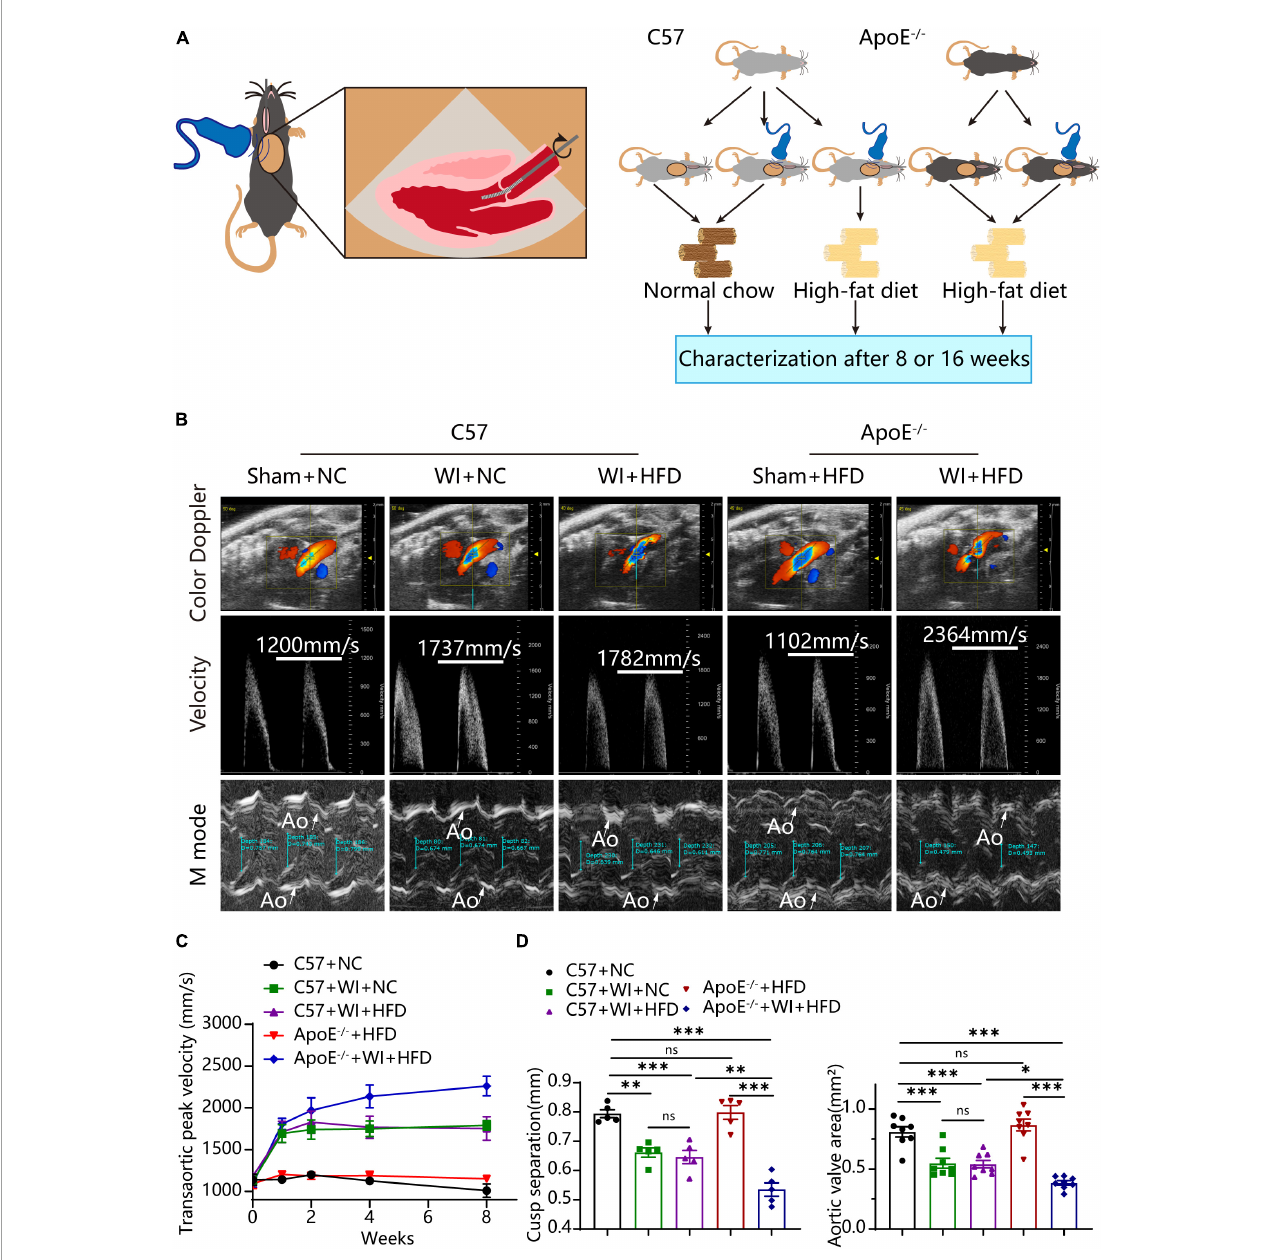
FIGURE1 Combined mechanical injury and hyperlipidemia caused aortic valve stenosis. (A) Schematic overview of the experimental strategy. C57 or ApoE − / − mice treated with wire injury and received normal chow (NC) or high-fat diet (HFD) for 8 or 16 weeks. (B) Representative color doppler, transaortic peak velocity and cusp separation 8 weeks after wire injury. White arrows indicated the aorta (Ao). (C) Time course of aortic valve velocity evaluated by echocardiography at 0, 1, 2, 4, 8 weeks after wire injury ( n = 8 per group). (D) Representative cusp separation ( n = 5 per group) and aortic valve area evaluated 8 weeks after wire injury ( n = 8 per group). Results are mean ± SEM. Adjusted P values were provided in case of multiple groups. ns. indicates non-significant P value. * P < 0.05, ** P < 0.01, and *** P <